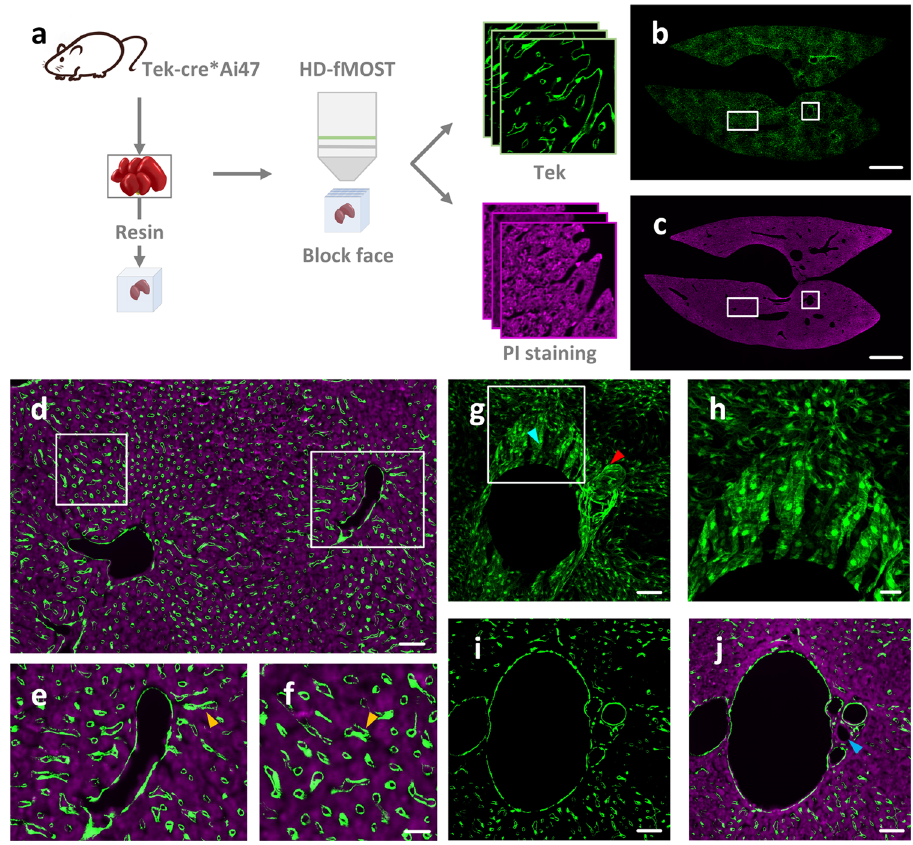
Fig. 1 The data acquisition pipeline and acquired results. a The procedure of acquiring dual-wavelength image dataset by high-de fi nition fl uorescent micro-optical sectioning tomography (HD-fMOST). b The slice image from the vascular channel of the intact mouse liver dataset. c The slice image from the cytoarchitecture channel of the intact mouse liver dataset. d The zoom-in of the merged channel images indicated in the white boxes in ( b ) and ( c ). e , f The zoom-in of the area indicated by the white boxes in ( d ). The yellow arrows indicate sinusoids. g The zoom-in of the merged channel images indicated in the white boxes in ( b ). The cyan arrow indicates portal vein. The red arrow indicates hepatic artery. h The zoom-in of the merged channel images indicated with a white box in ( g ). i Portal triads in vessel channel image. j Portal triads in merged dual-channel image. The blue arrow indicates bile ducts. The projection thickness of ( b , c , g ) is 100 µ m, and the thickness of ( d – f , h – j ) is 1 µ m. Scale bars, b , c 1 mm; d , g – j 50 μ m; e , f 20 μ